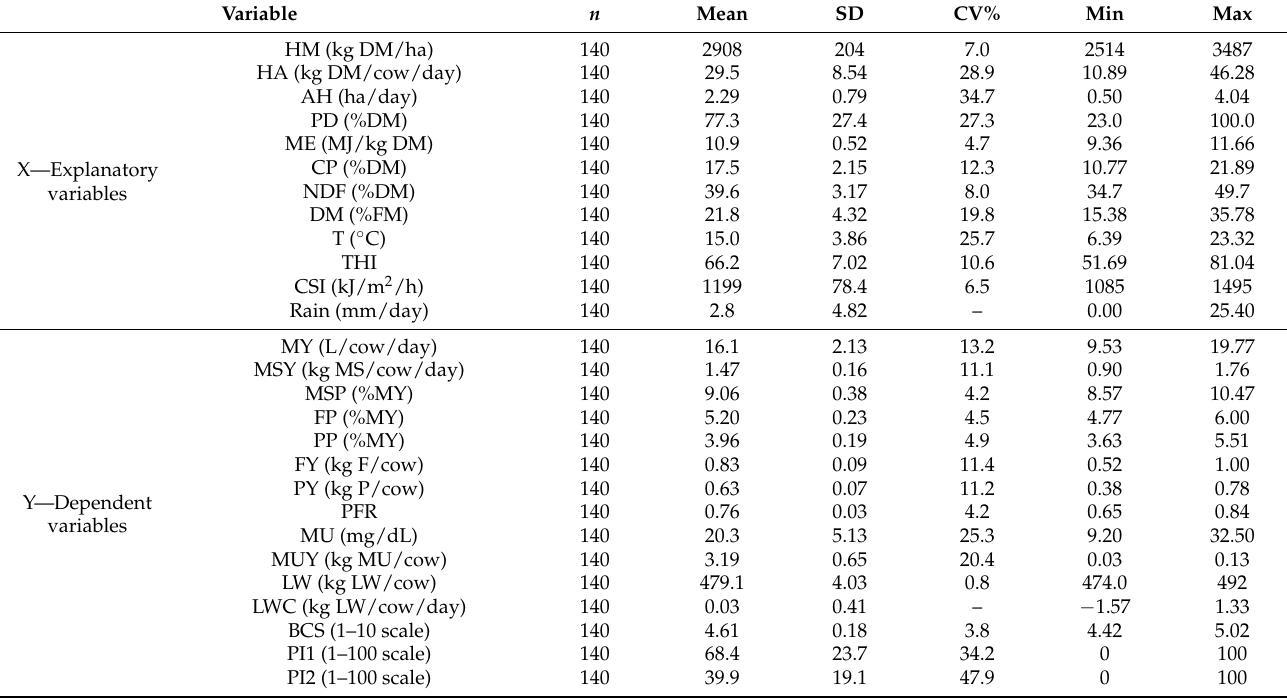
Table 3. Descriptive statistics of herbage nutritive value, herbage quantity and climate explanatory variables and perfor- mance per cow response variables used in this